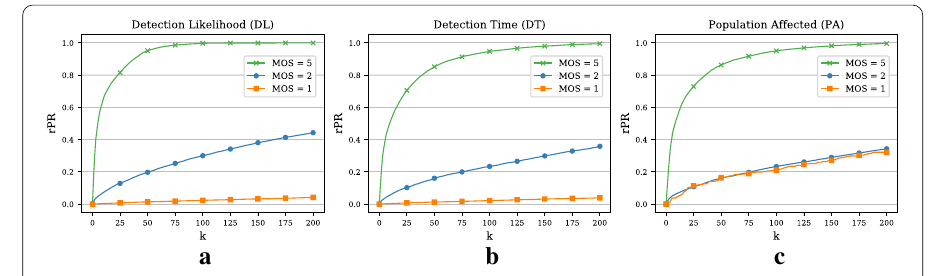
Fig. 10 Effect of minimal outbreak size (Example 2). a Relative penalty reduction for the DL objective and different minimal outbreak sizes (MOS). b Relative penalty reduction for the DT objective and different MOS. c Relative penalty reduction for the PA objective and different